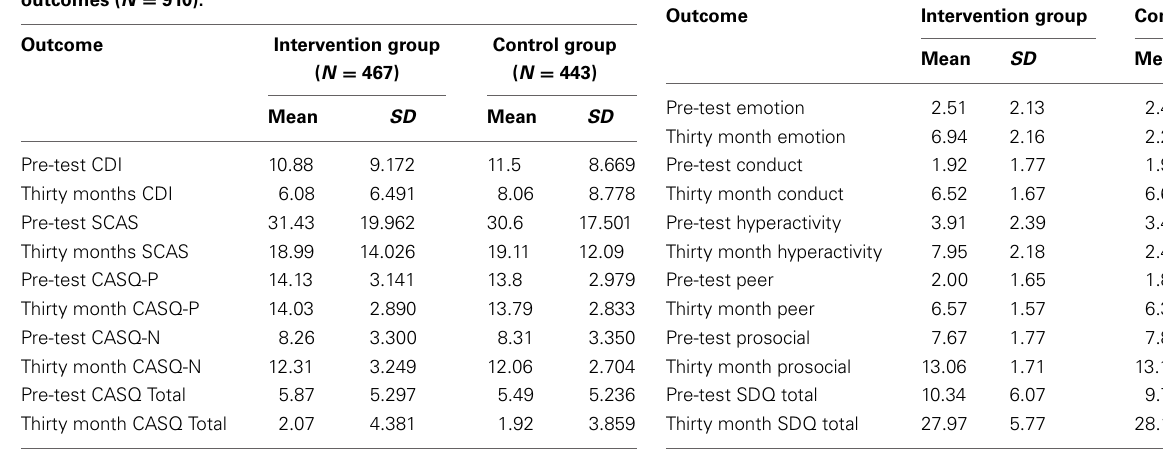
Table 1 | Means and standard deviations for the student-reported outcomes ( N = 910).